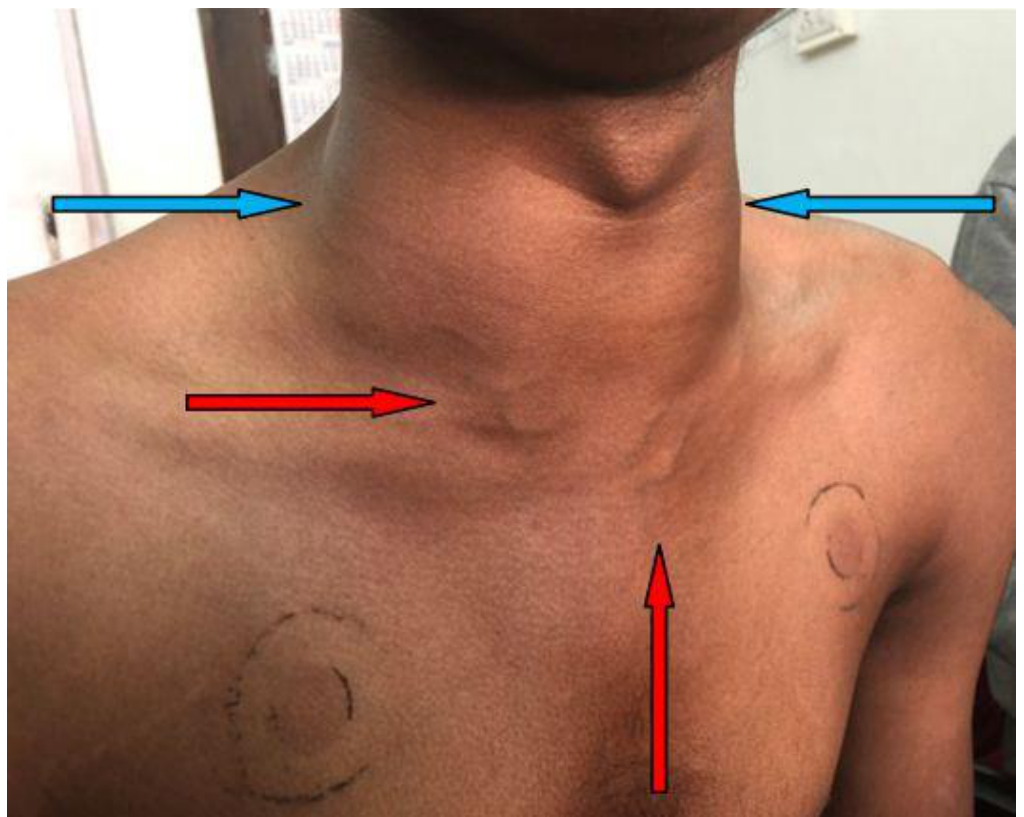
Figure 1. Neck swelling depicted by blue arrows; Prominent engorged veins depicted by red arrows, a presenting symptom of superior vena cava